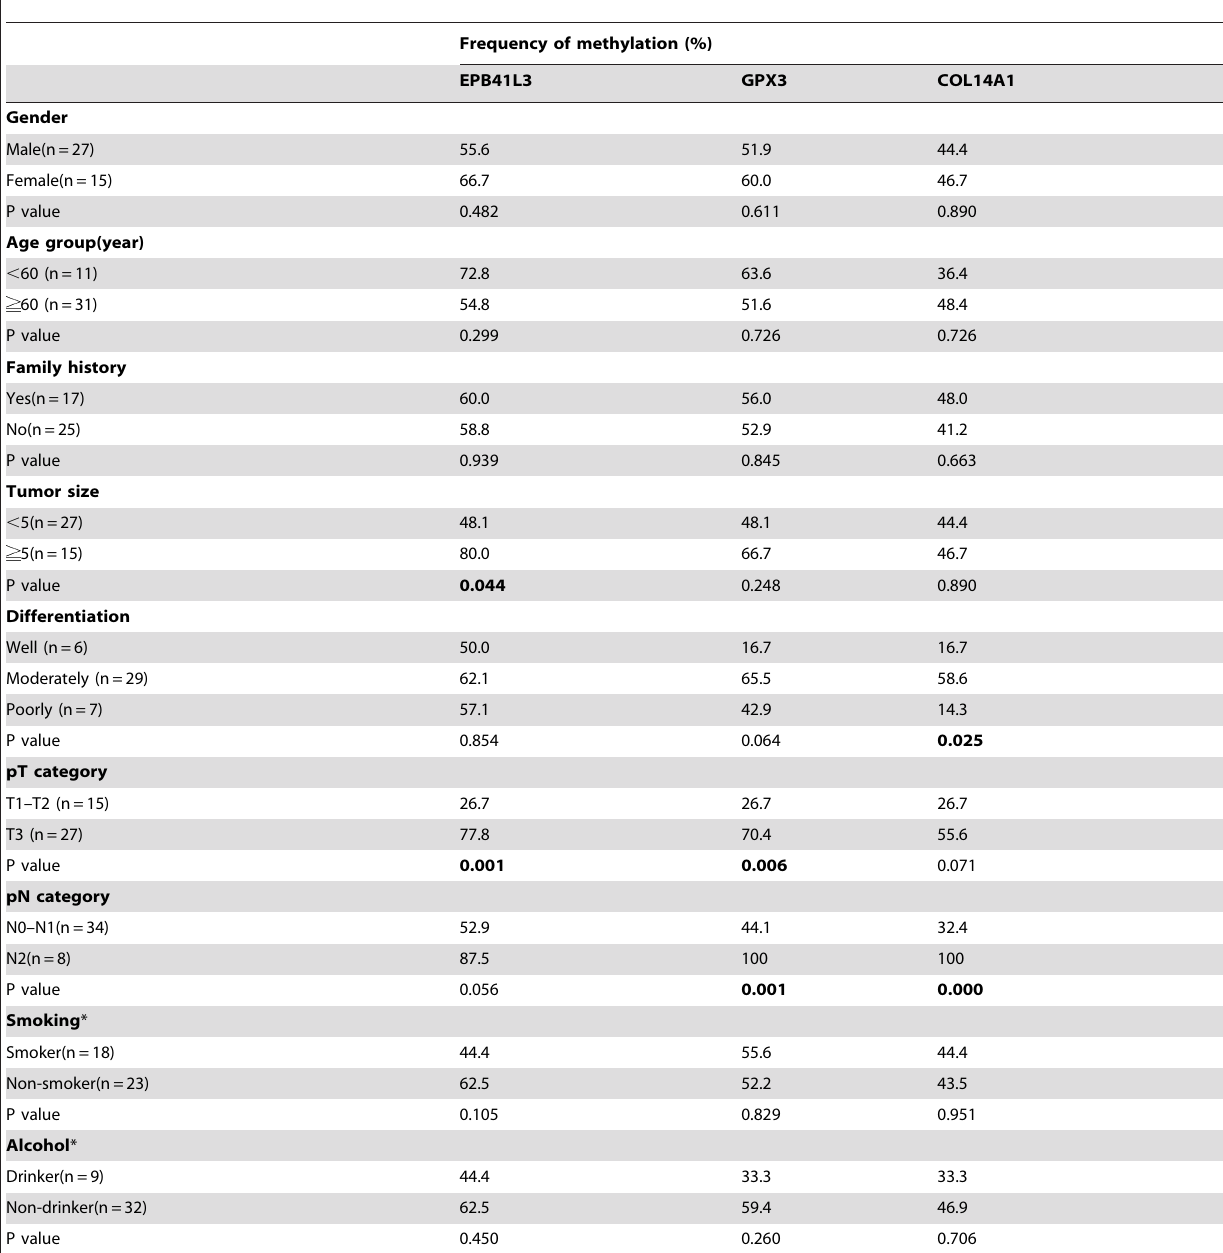
Table 4. Correlation Between DNA Hypermethylation and Clinico-pathological Parameters of Esophageal Squamous Cell Carcinoma Patients